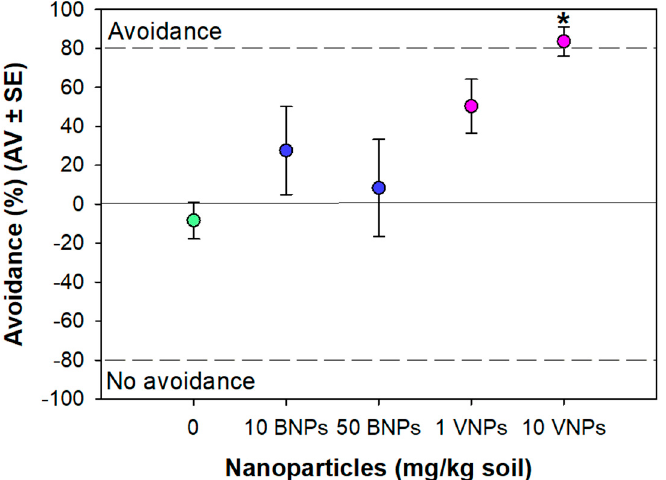
Figure 6. Avoidance responses of Enchytraeus crypticus after 48 h exposure to boron nanoparticles (BNPs) and vanadium nanoparticles (VNPs) in LUFA 2.2 soil. Results are expressed as average value (AV) ± standard error (SE) (n = 5). * Significant differences to control ( p < 0.05).